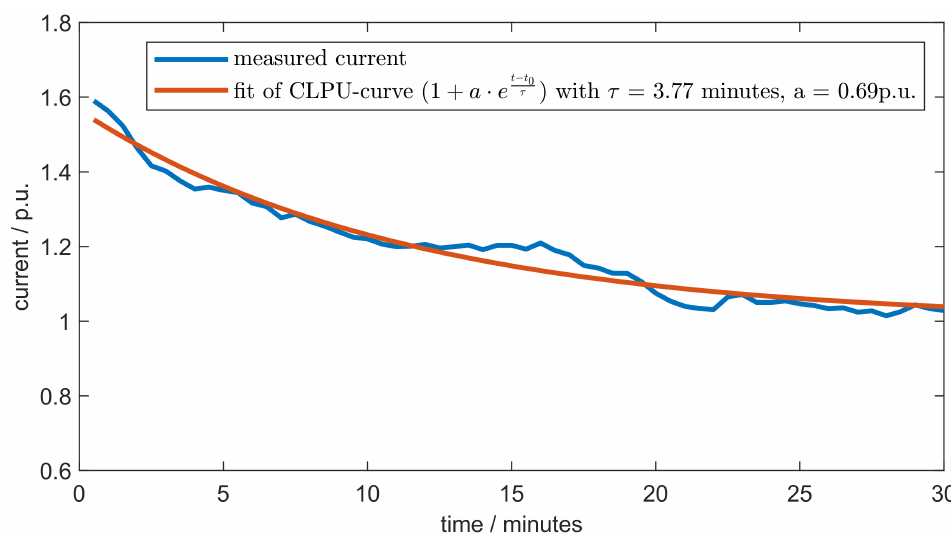
Figure 4. Normalized mean current of the 31 reconnection events and fitted CLPU